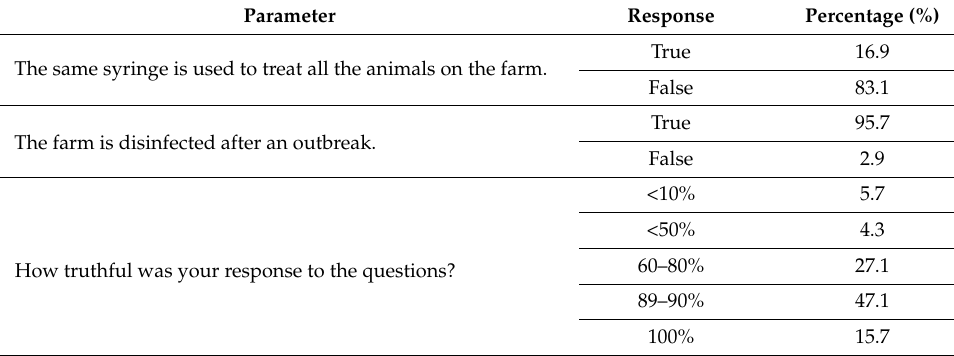
Table 12. Cont. Parameter Response Percentage